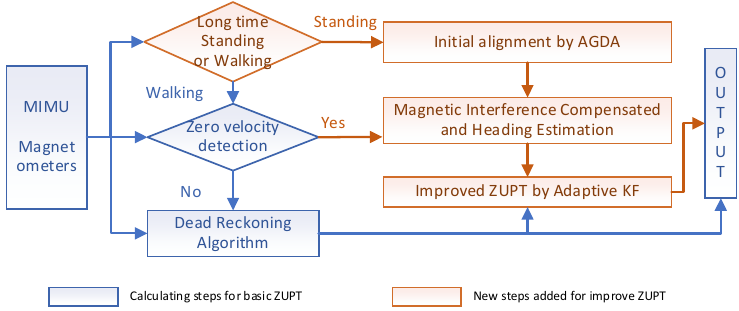
Figure 5. Schematic diagram of the improved algorithm for FIPPS.